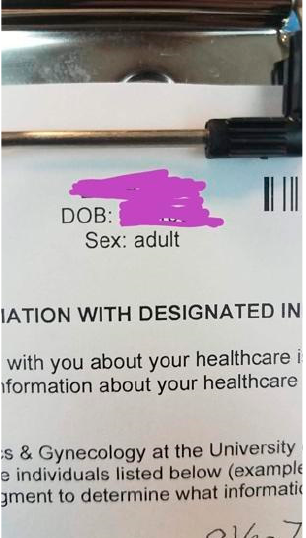
Figure 3. “Healthcare Euphoria” (Cory).